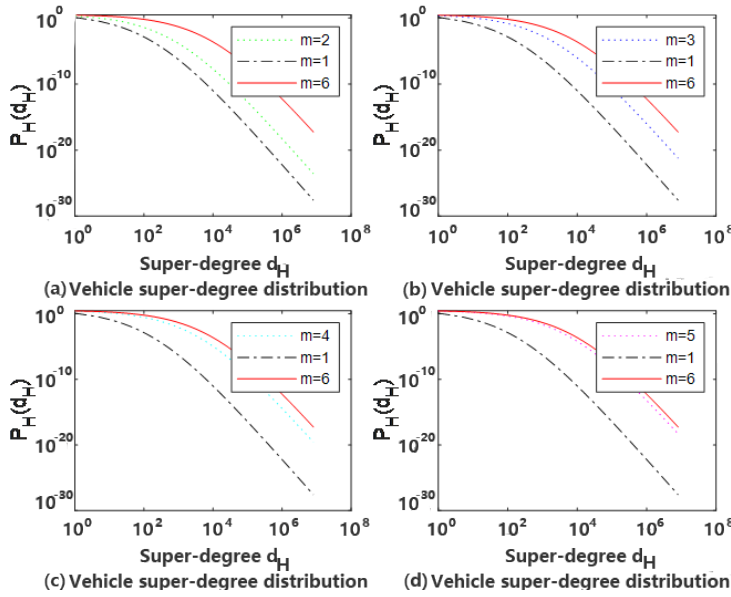
Figure 4. The characteristics with different m .